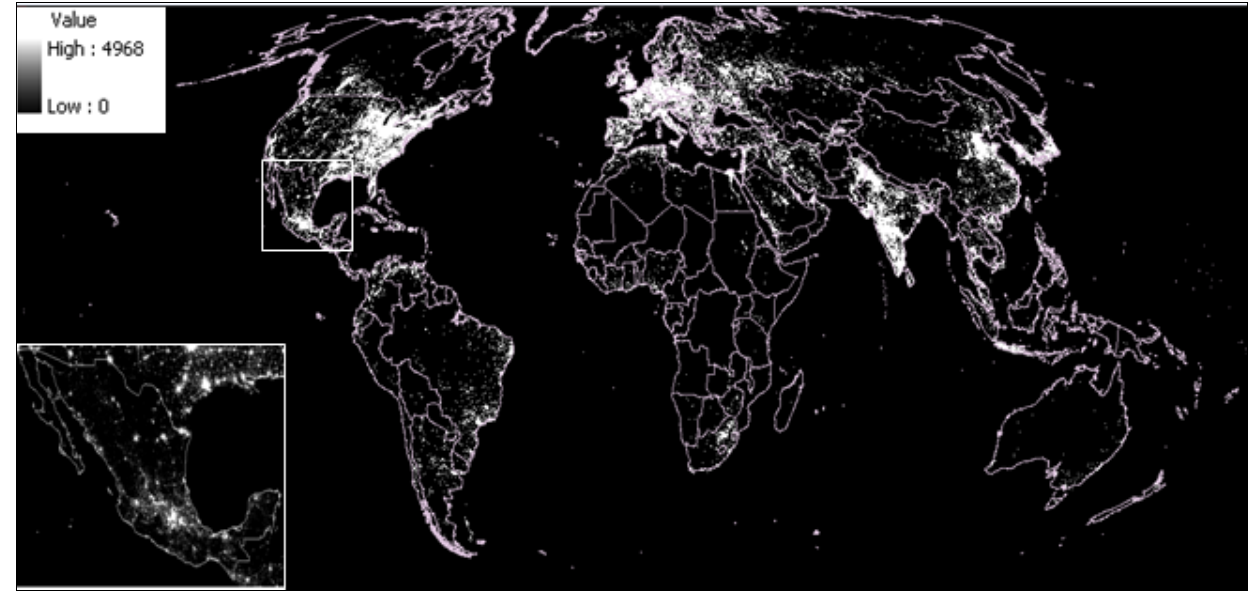
Figure 1. Radiance calibrated nighttime image of 2000-2001, Mexico in the